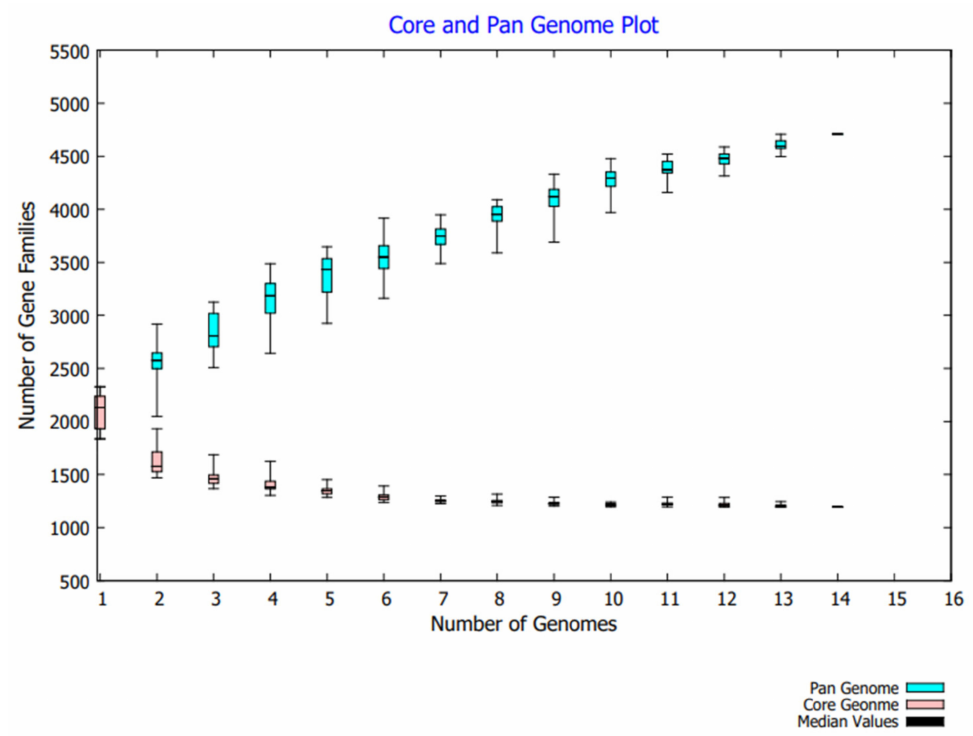
Figure 1. Pan-genome analysis of 14 F. nucleatum strains related to